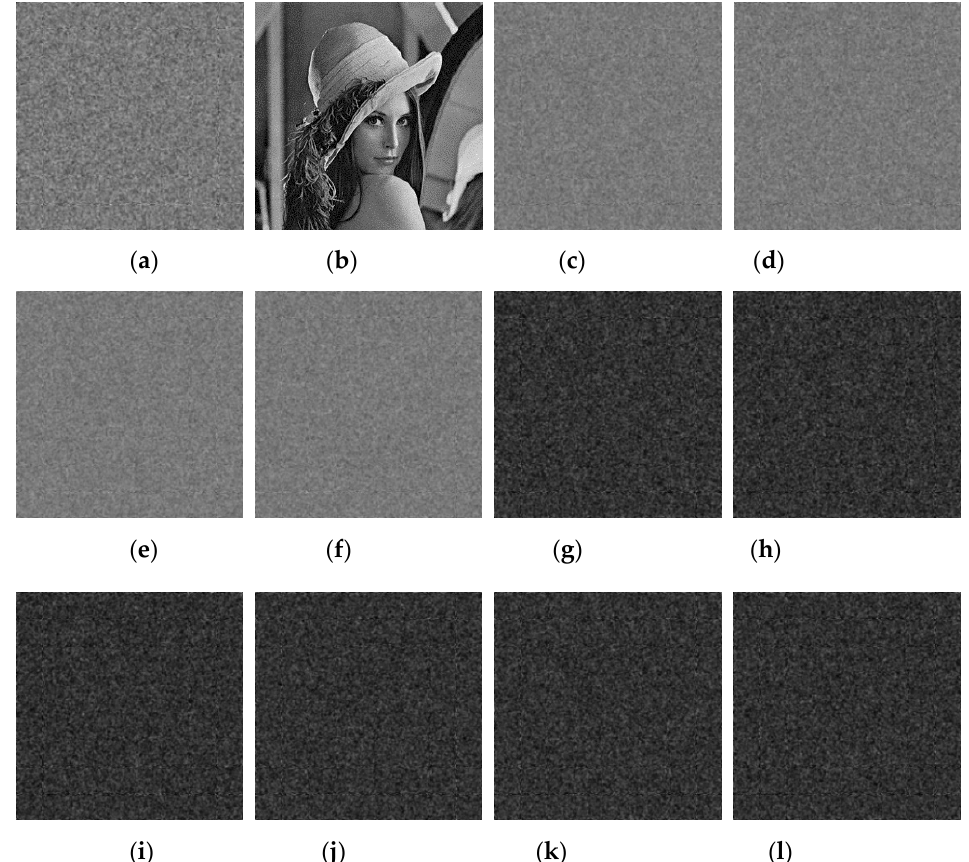
Figure 12. Key sensitivity test: ( a ) Initial encryption; ( b ) Decryption with correct keys; ( c ) Decryption with x 0 (cid:48) = 0.986500000000001; ( d ) Decryption with y 0 (cid:48) = 1.433500000000001; ( e ) Decryption with z 0 (cid:48) = 1.497700000000001; ( f )